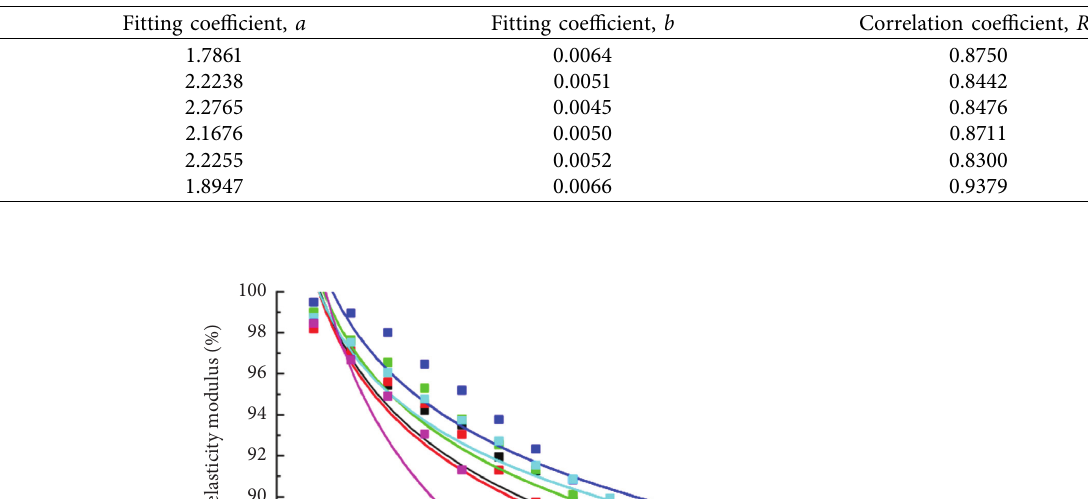
Table 11: Compressive strength accumulative damage exponential function and pertinence coefficient.